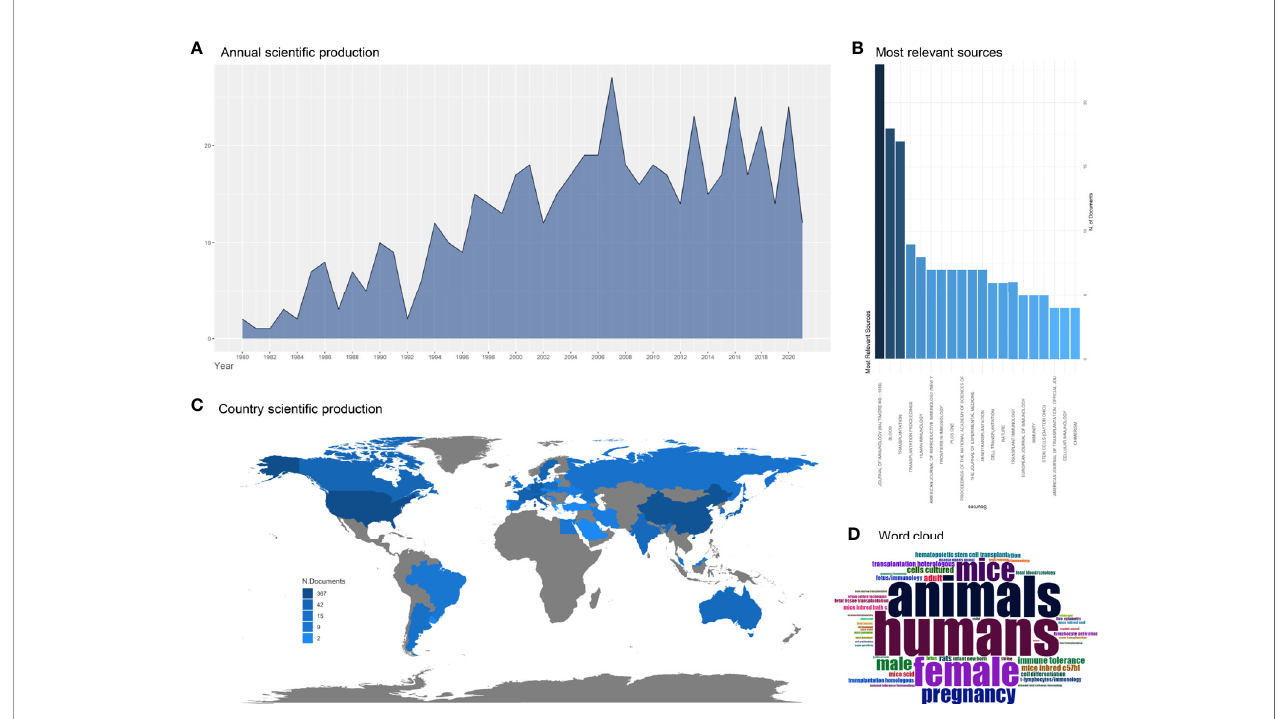
FIGURE 3 | Trends of the research in placental immunity and organ transplantation. The search strategy is ((((((fetal) OR (placenta*)) OR (maternal-fetal interface)) AND (immune)) AND (organ)) AND (transplantation)) AND (( “ 1980 ” [Date - Publication]: “ 2021 ” [Date - Publication])). (A) The annual scienti fi c production shows an increasing trend from 1980 to 2021. (B) The most relevant sources of these published studies. The top three relevant sources are Journal of immunology , Blood , and Transplantation . (C) Country scienti fi c production. The color indicates the number of the related studies in each country. (D) Word cloud is based on the keywords from the published